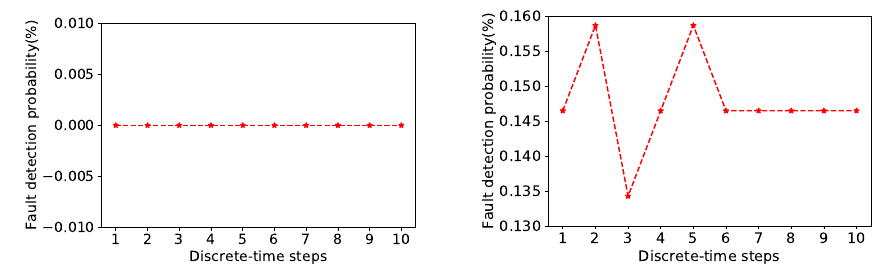
Figure 8: The fault detection probabilities for FIRO and GARO with different i .